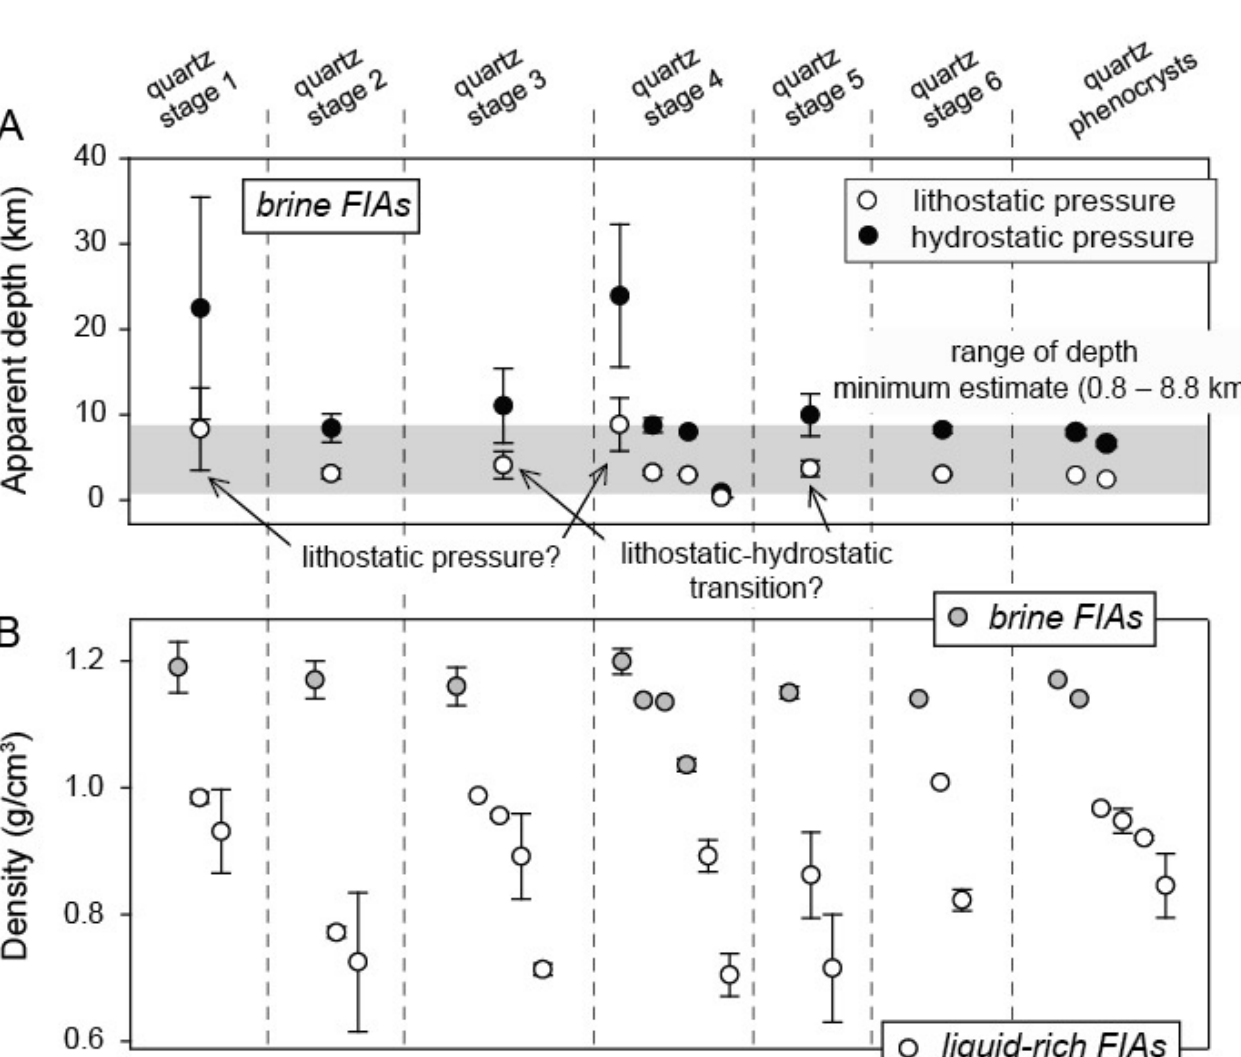
Figure 5. Sequences of ( A ) calculated apparent paleodepths from brine inclusion assemblages and ( B ) calculated densities of liquid-rich and brine fluid inclusions assemblages (FIA) in early UST quartz stages (1–6) and postdating quartz phenocrysts. ( A ) We assumed densities of 2.7 and 1 g/cm 3 to calculate lithostatic and hydrostatic pressures, respectively. Gray shaded area represents an estimated range of minimum apparent depth, which is more than 1–8 km if we assume the highest pressure (2300 bars) as a lithostatic, and the lowest pressure (80 bars) as a hydrostatic. ( B ) Densities of the brine and liquid-rich FIAs were calculated from salinities and homogenization temperatures (vapor + liquid → liquid) using a model NaCl-H 2 O system [47].